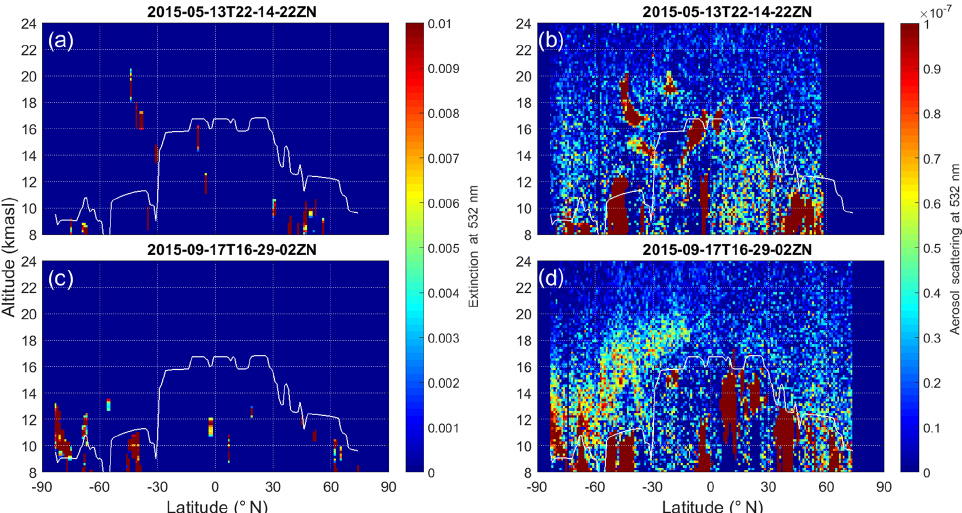
Figure 3. Comparisons of the particle extinction parameter from the level 2 data v4-10 (a, c) and the aerosol scattering (b, d) taken after the Calbuco eruption. The upper figures were taken 3 weeks after the eruption (on 13 May 2015), and the lower almost 4 months after the eruption (on 17 September 2015). Data in b and d were based on the attenuated backscattering at 532nm in the level 1 v4-10 data, and modeling of the molecular scattering. The white lines mark the thermal